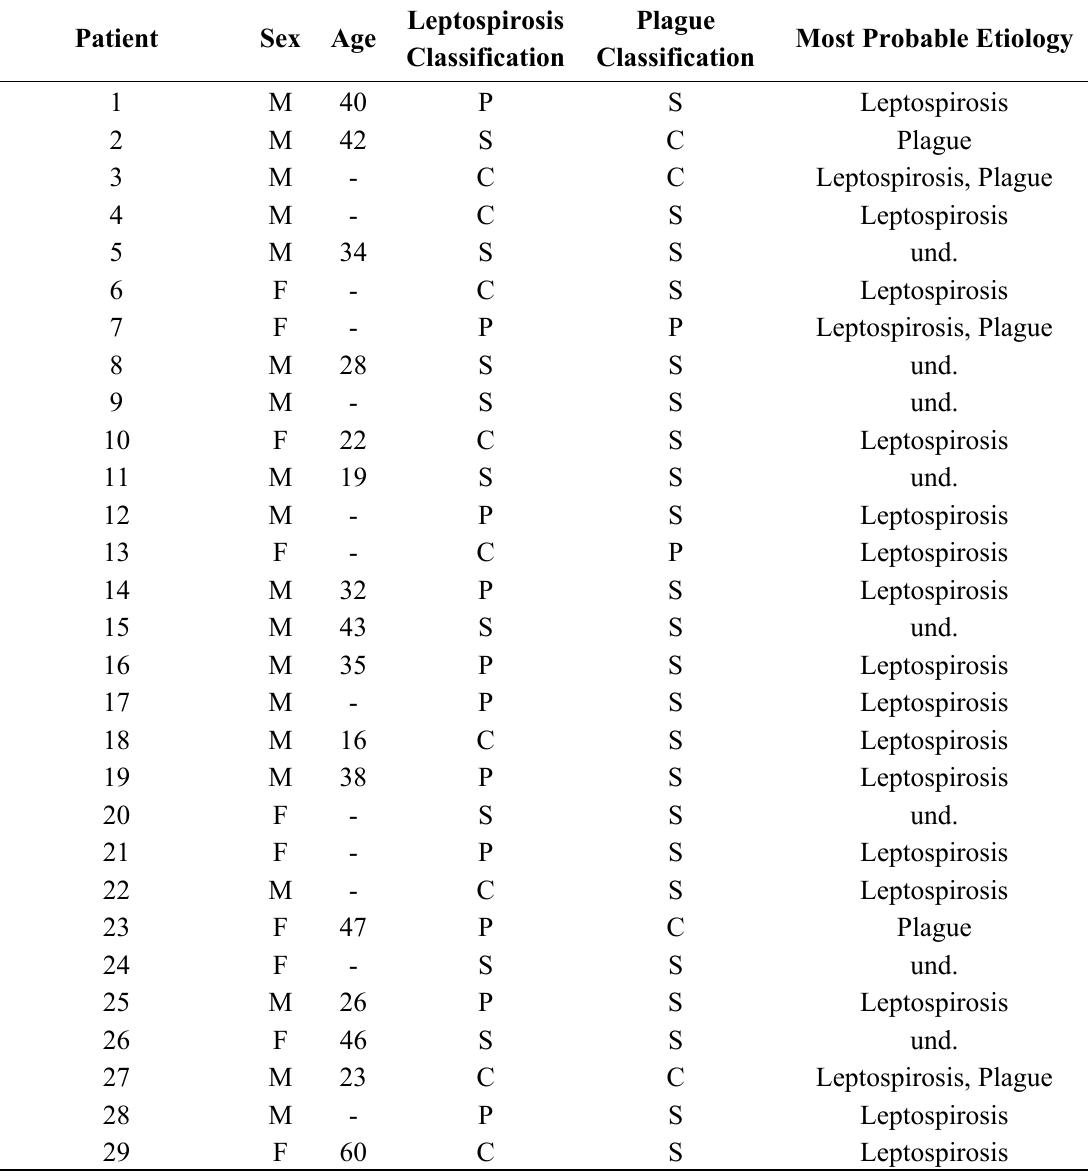
Table 2. Etiology of 29 leptospirosis seropositive patients tested during the pneumonic plague outbreak, DRC,